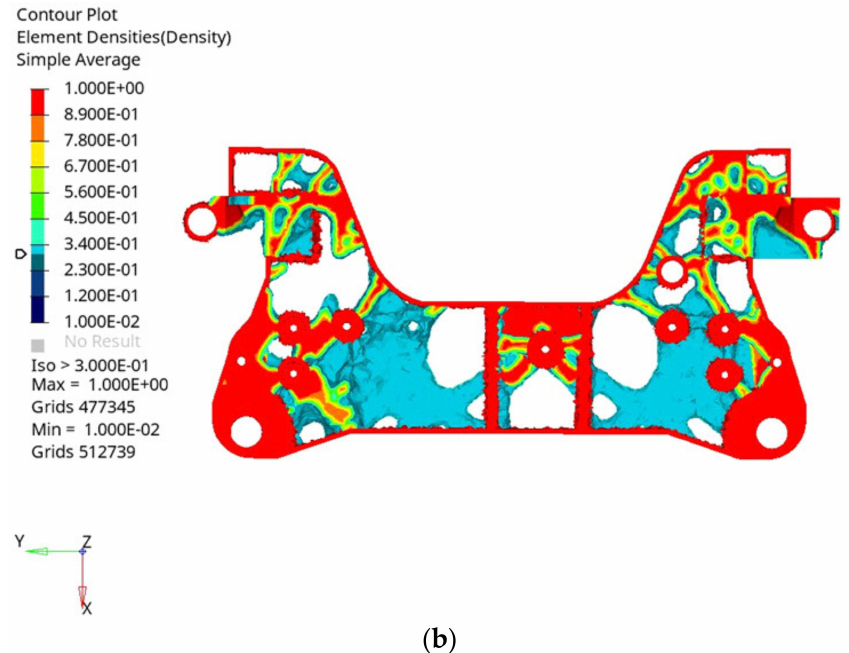
Figure 2. Topology optimization results of aluminium alloy front subframe envelope under multiple working conditions. ( a ) Positive results of multi-condition topology optimization. ( b ) Rear result of multi-condition topology optimization.